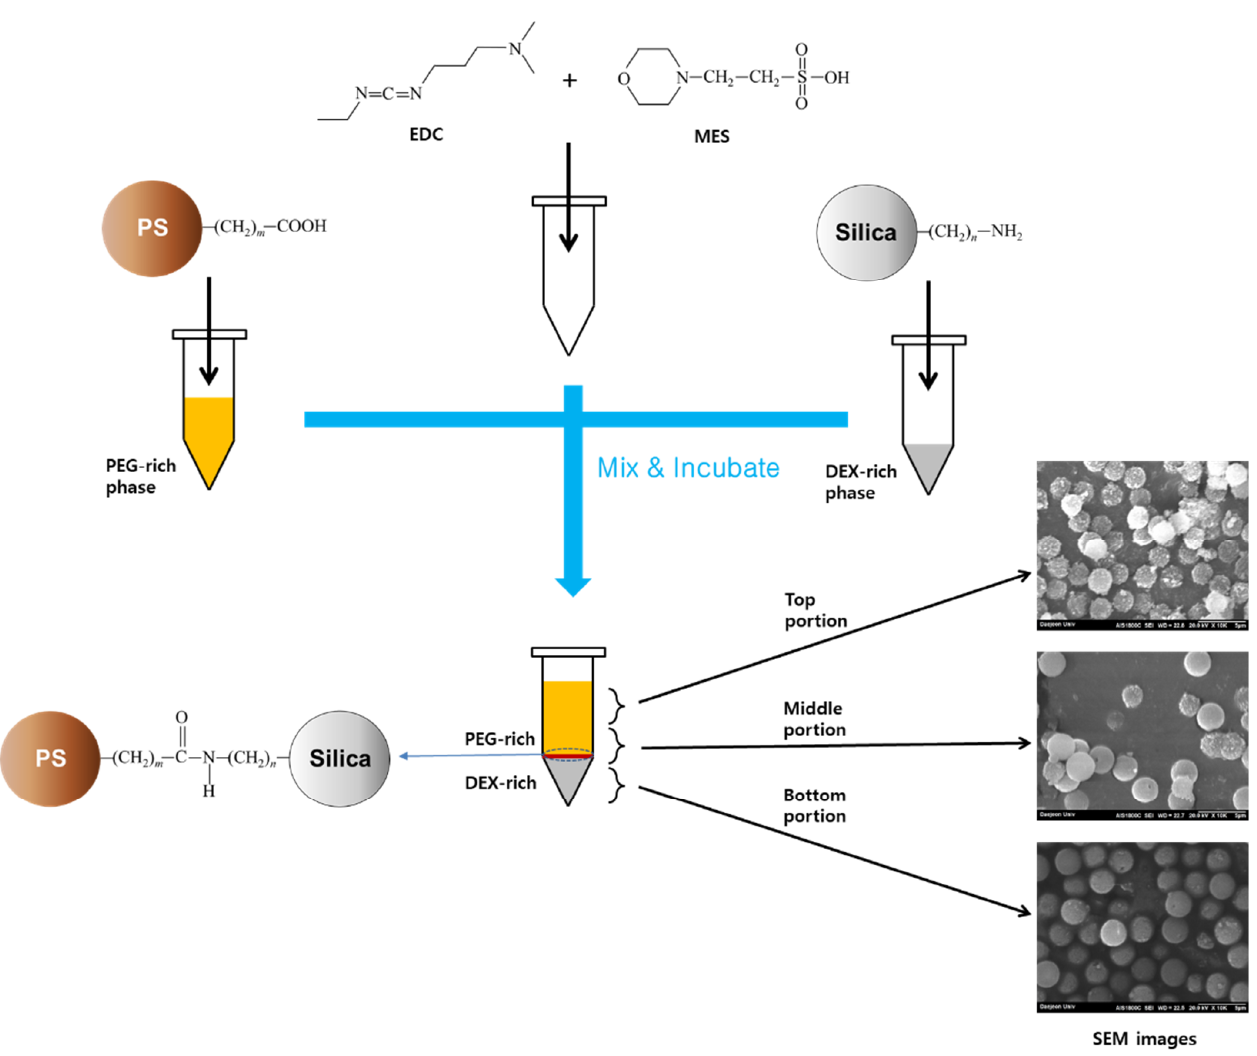
Figure 2. Preparation of Janus dumbbell particles in PEG-DEX ATPS. Details were shown in Mate- rials and Methods.